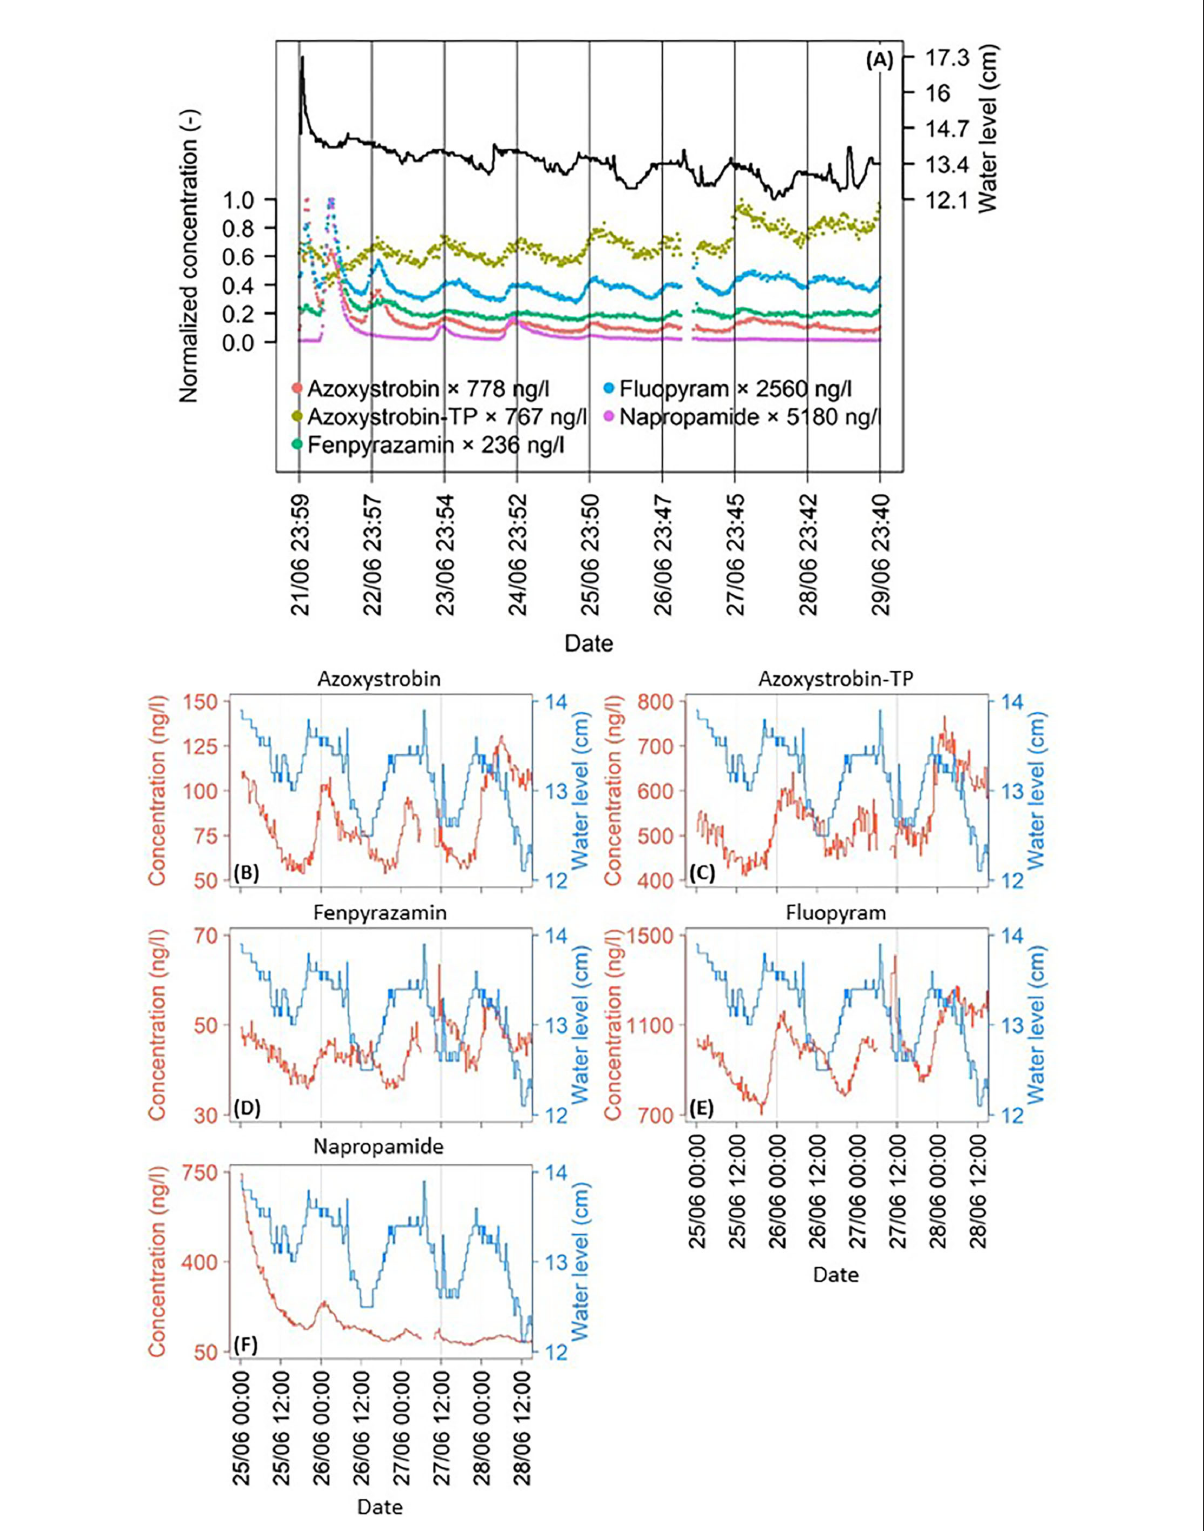
FIGURE4 (A) Time series of PPPs and TPs normalized concentrations that showed diel fluctuations. Concentrations to be multiplied by the corresponding maximum value in the legend. The dash black line depicts the water level. No measurements on June 27 th from 06:11 to 10:12 because the solution containing isotope-labeled internal standards had to be replenished. Concentrations below LOQ are not shown. Peaks in water levels